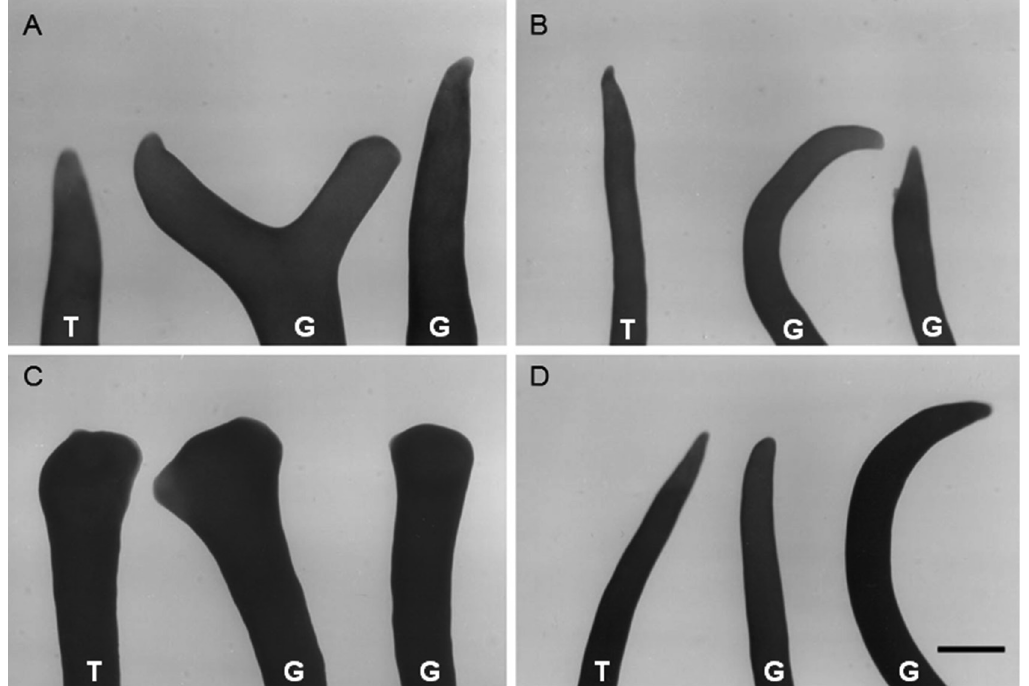
Fig. 2. – Morphology of apical tips of tetrasporophytes (T) and gametophytes (G) of Gracilaria birdiae cultivated in 8L:16D under different light qualities. A. White, WH; B, Green, GR; C, Red, RD; and D, Blue, BL. The same morphological variations were observed in thalli cultivated in different light qualities under 14L:10D (data not shown). Bar scale: 1